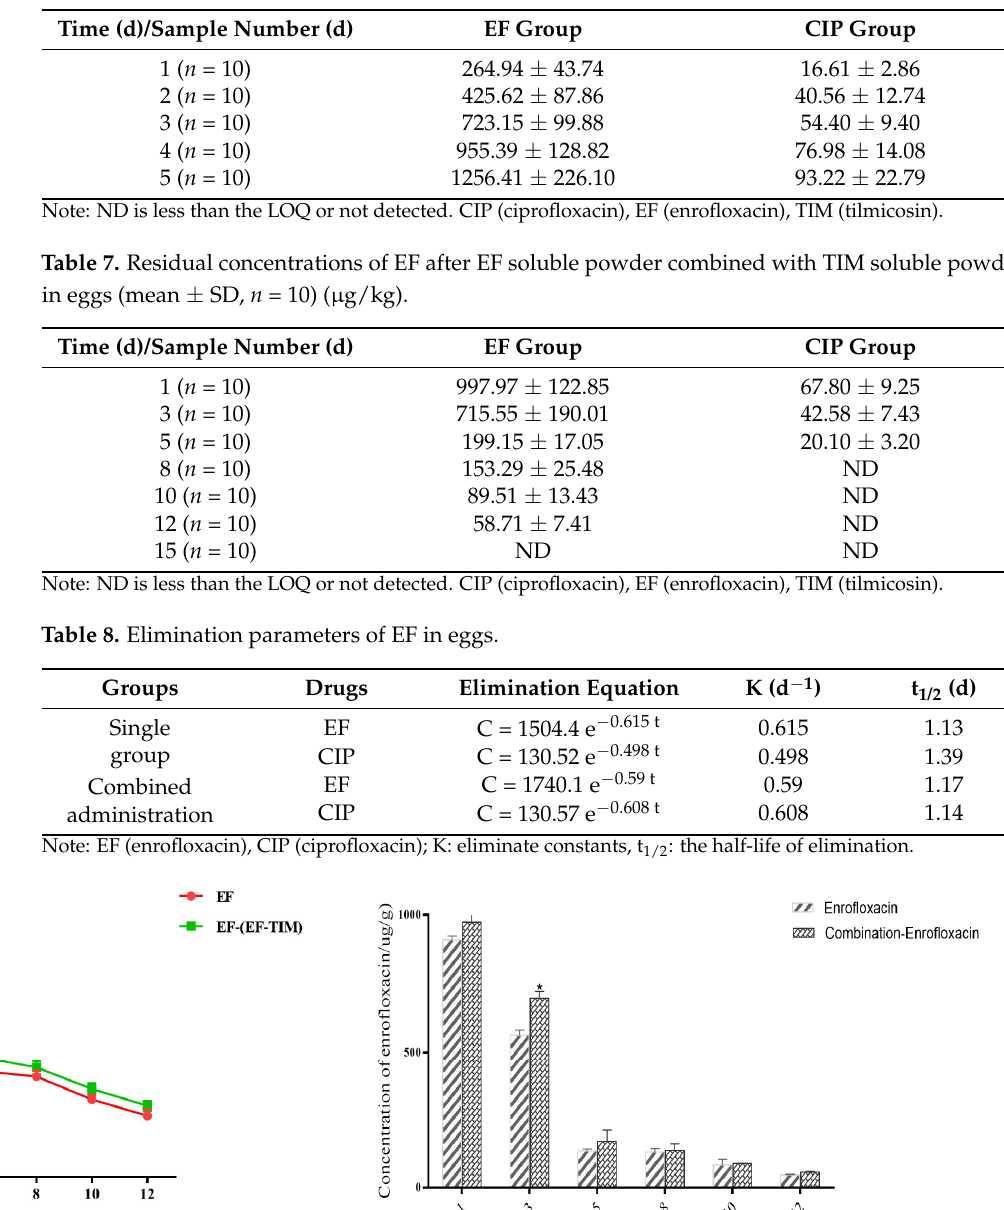
Table 6. Residual concentrations of EF during EF soluble powder combined with TIM soluble powder in eggs (mean ± SD, n = 10) ( µ g/kg).